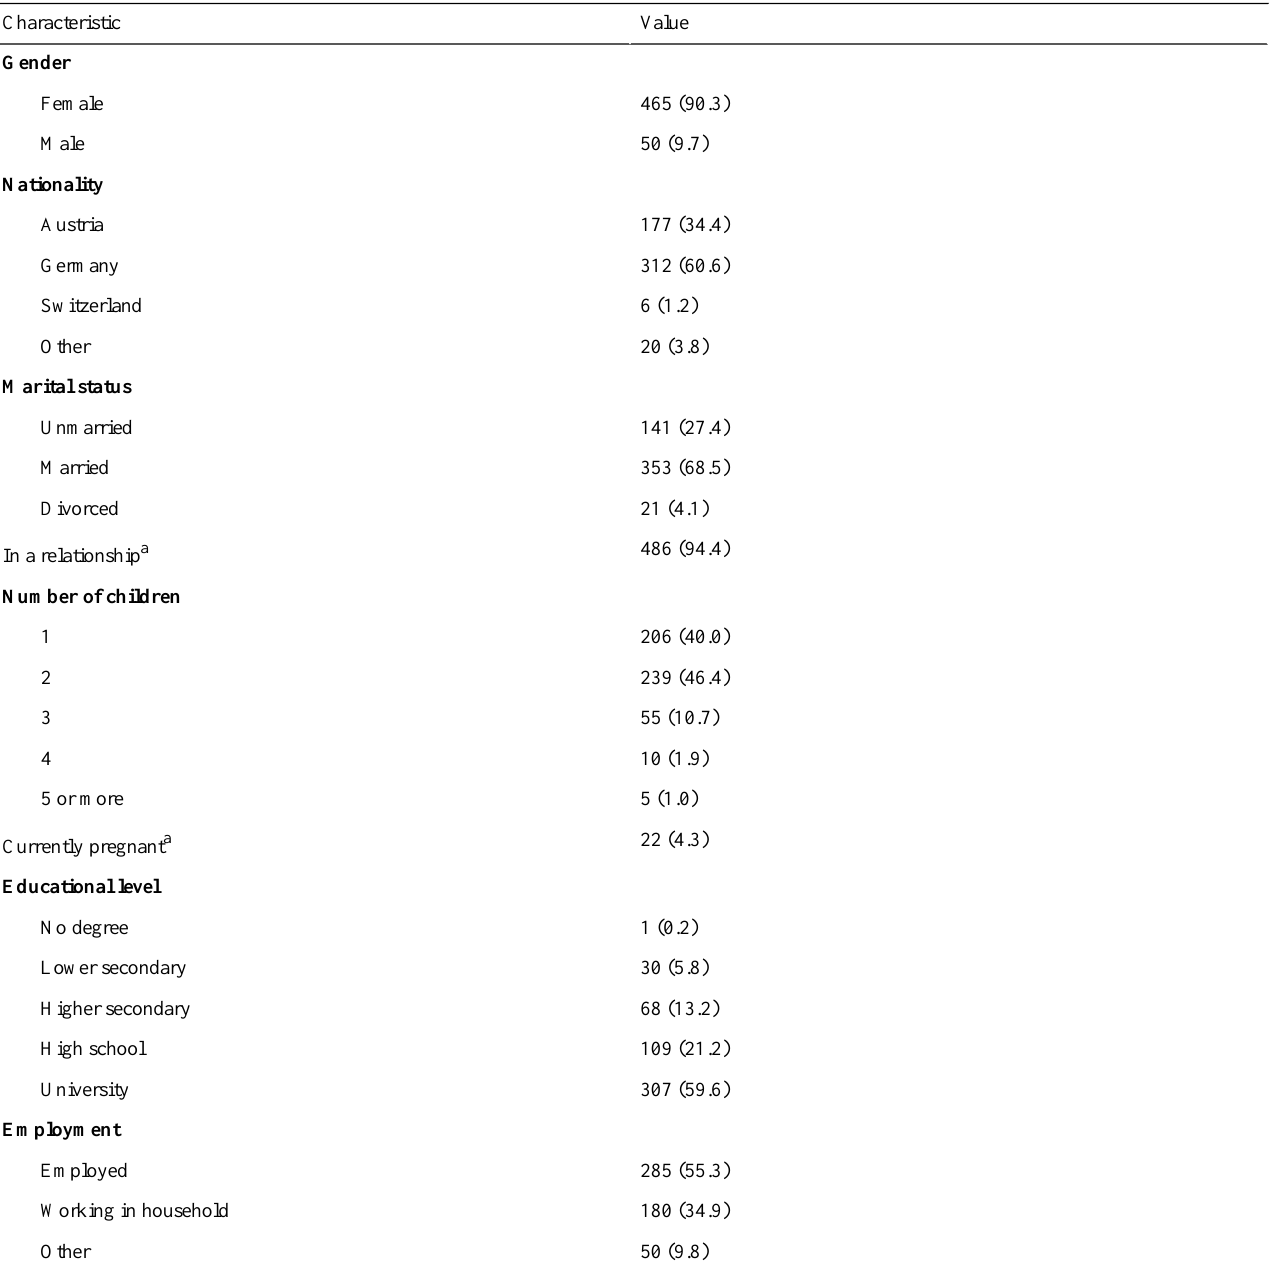
Table 1. Sociodemographic characteristics of the study participants (N=515), n (%). The average age of the participants was 34.95 years (SD